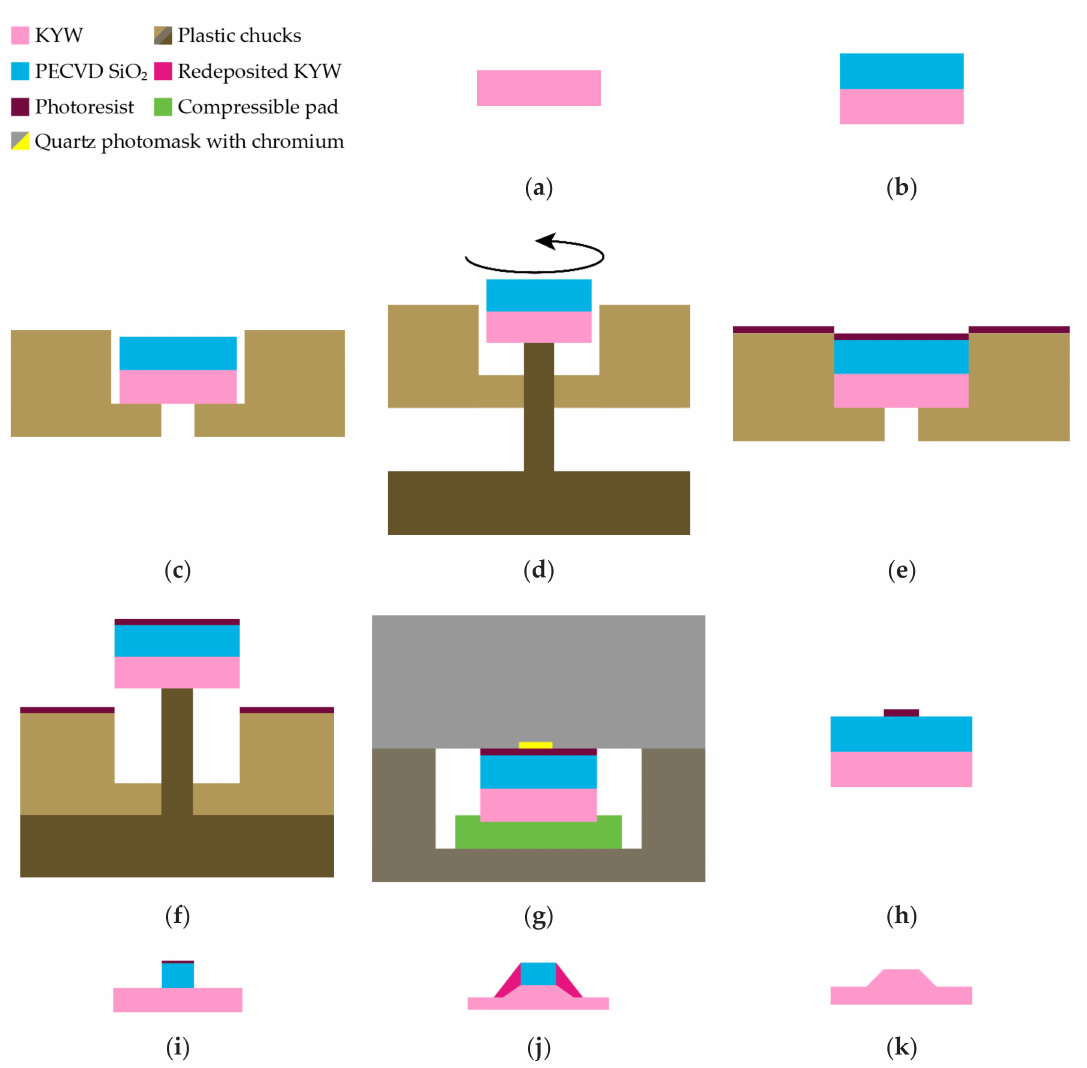
Figure1. Completeprocessflowforsamplefabrication. ( a )InitialKY(WO 4 ) 2 sample.( b )Plasma-enhanced chemical vapor deposition (PECVD) of SiO 2 hard mask layer. ( c ) Mounting of sample in spin coating chuck. ( d ) The base tool is used to lift the sample and rotate it into corner contact with the chuck edges. ( e ) Edge bead-reduced spin coating of photoresist. ( f ) Retrieval of sample from the spin coating chuck using the base tool. ( g ) Photolithography exposure using custom mount. ( h ) Development of photoresist. ( i ) Inductively coupled plasma reactive ion etching (ICP-RIE) to open SiO 2 hard mask. ( j ) Ar-based ICP-RIE etch to pattern KY(WO 4 ) 2 . ( k ) Redeposition stripping using 20% HCl at 80 ◦ C and mask removal in